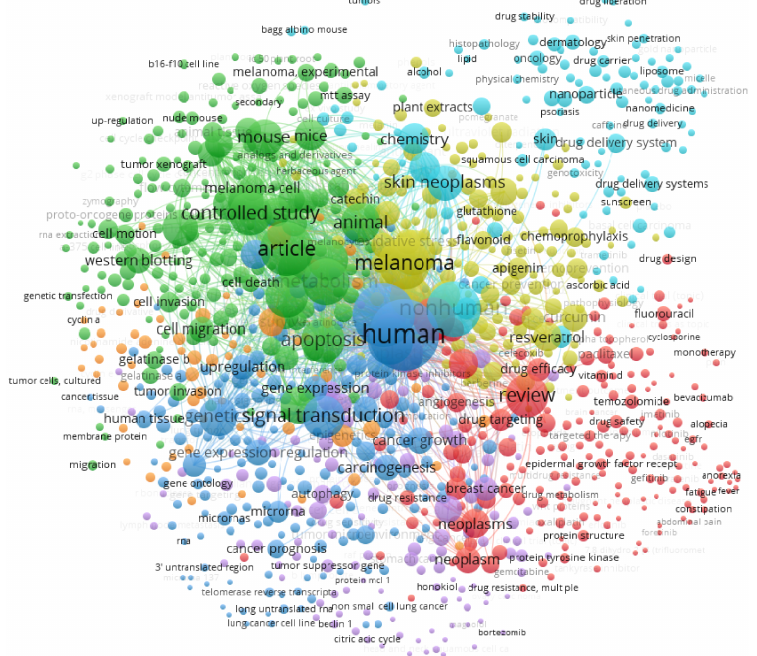
Figure 1. The bibliometric map obtained by VOSviewer software version 1.6.16 [18] using “cutaneous melanoma” AND “apigenin” OR “EGCG” OR “kaempferol” OR “naringenin” OR “Silybin” as keywords, recorded from the Scopus